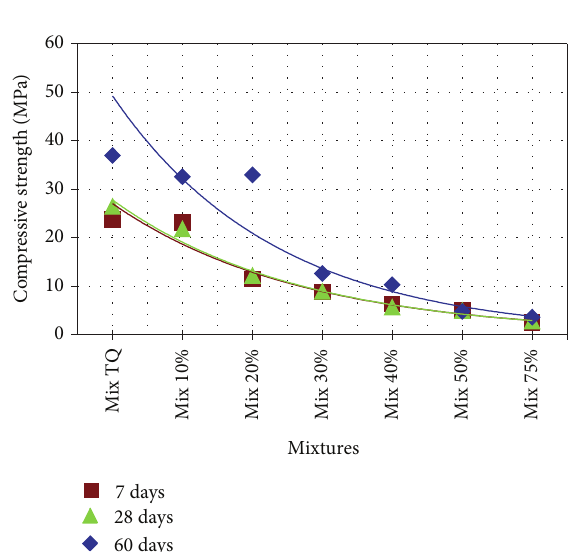
Figure 5: Compressive strength of rubber cement composites on days 7, 28, and